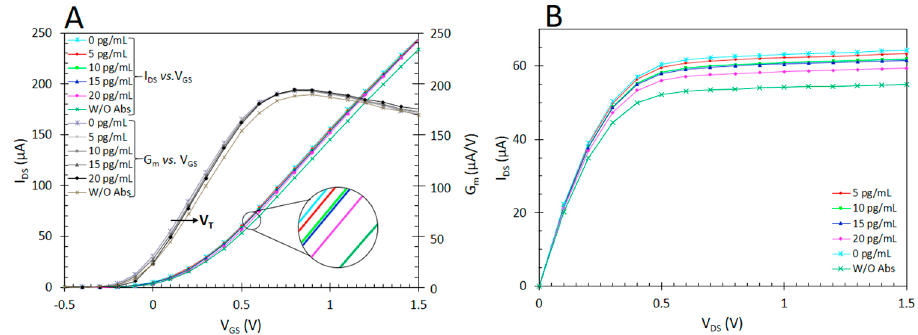
Figure 5. ImmunoFET characteristics for TNF- α detection in phosphate buffer saline (PBS) solution under various TNF- α concentrations: ( A ) electrical characteristics (I DS vs. V GS ) of the ImmunoFET at constant V DS value (0.5 V); ( B ) output characteristics (I DS vs. V DS ) of the ImmunoFET under constant V GS value (0.5